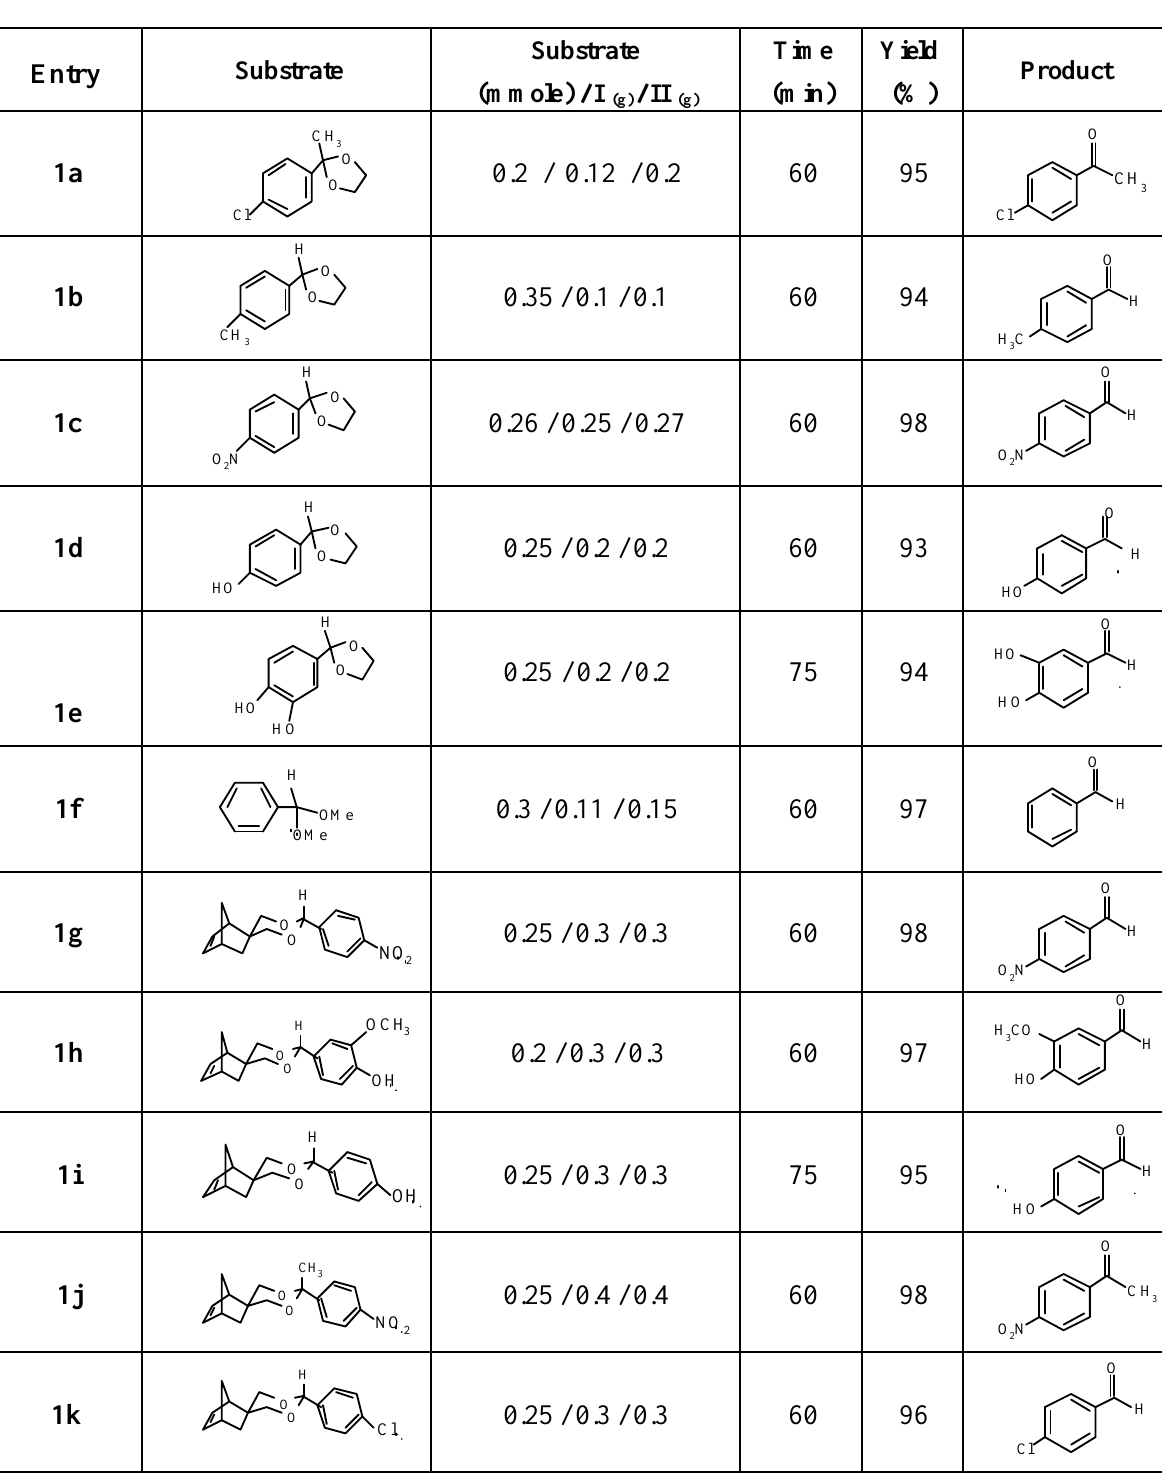
Table 1 : Deprotection of Acetals and Ketals in Toluene at 60-70